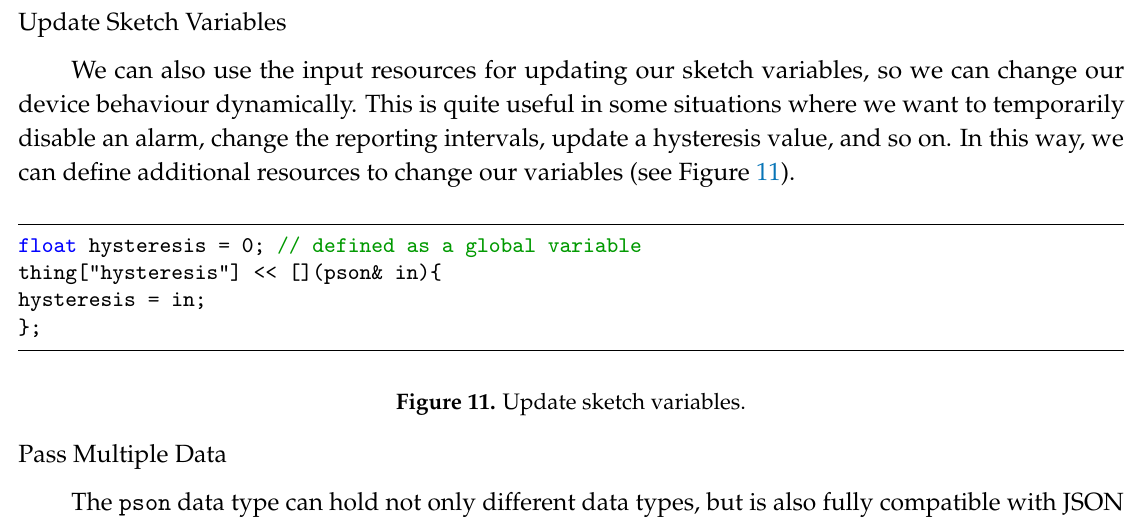
Figure 10. Modify a servo position.